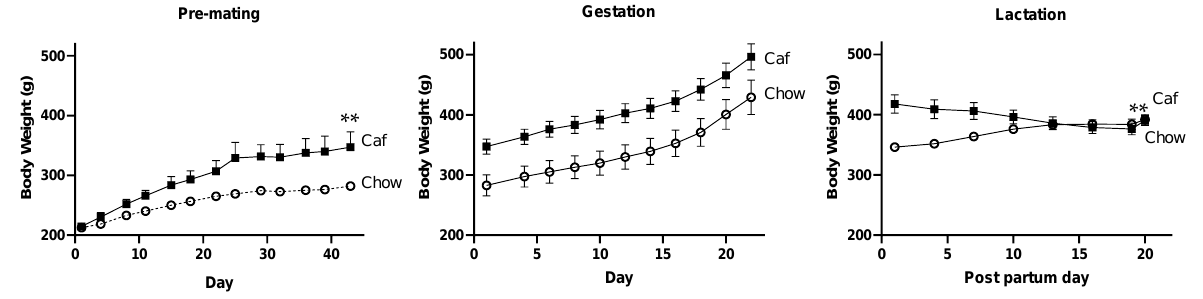
Figure 3. Body weight over time in female rats consuming chow or Caf diet, before mating, during gestation and lactation. Data are expressed as mean ± SEM of 11 chow and nine Caf females. Data were analysed by mixed ANOVA. ** p < 0.01, significant time × maternal diet interaction.